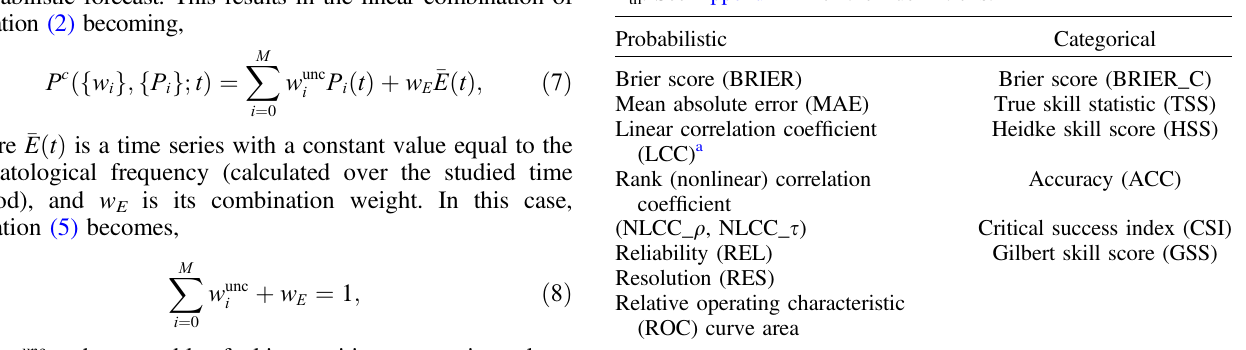
Table 3. Performance metrics tested in the optimization process. Each metric produces a different set of combination weights (i.e., a different ensemble). In each case a label is shown in parentheses that is used throughout the rest of the manuscript. Categorical metrics are calculated using 2 (cid:3) 2 contingency table after probabilistic forecasts are turned into deterministic forecasts by choosing a threshold value, P th . See Appendix A for their de fi